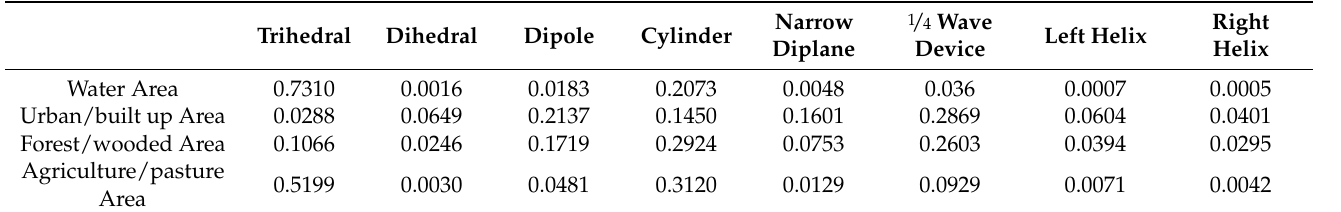
Table 5. Observation probability for each of the 8 scattering mechanisms for each land covers